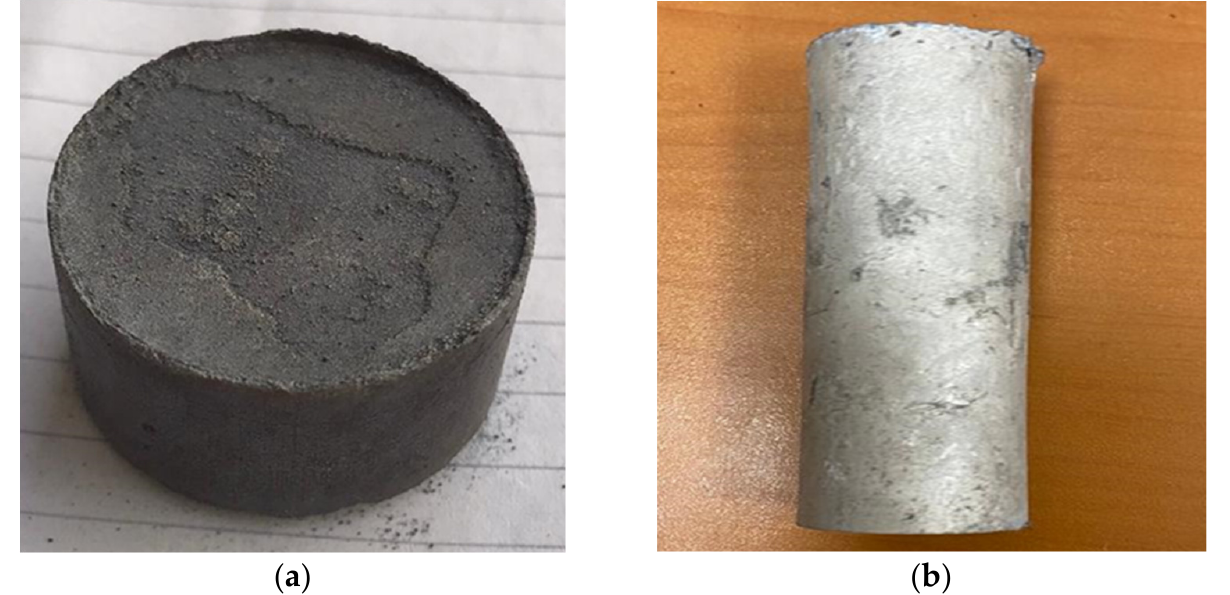
Figure 1. ( a ) Pressed compact capsules; ( b ) a sample of the cast